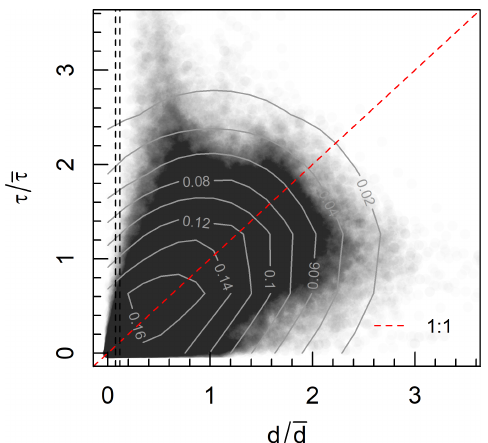
Figure 8. Relationship between local mean-normalised flow depth and shear stress across all experiments, produced by randomly sam- pling 10% of cells from each flow model. Contour lines represent 2D kernel density estimation, and vertical dashed lines indicate the range of flow depths used to threshold the flow